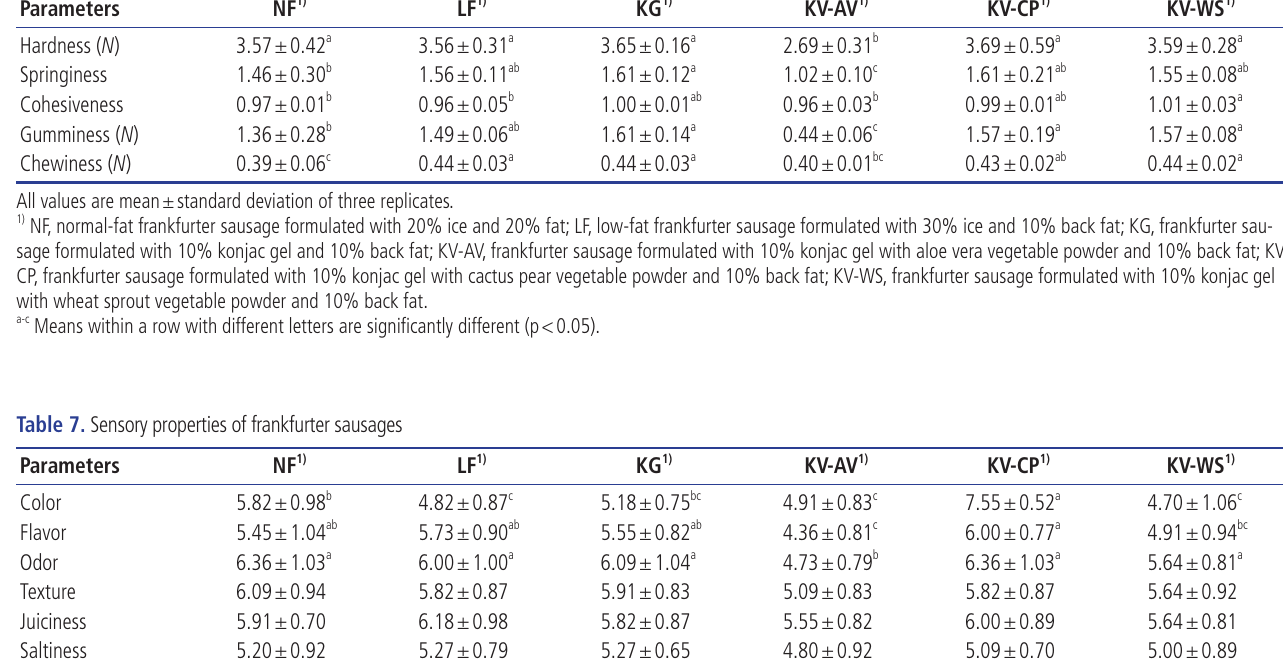
Table 6. Texture profile analysis of frankfurter sausages Parameters